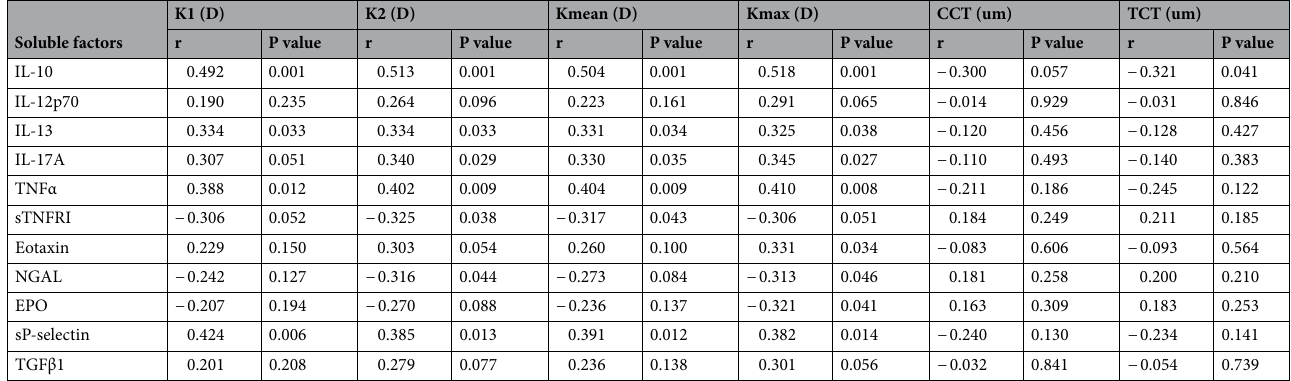
Table 3. Association of tear fluid soluble factor levels with corneal keratometry and pachymetry indices of KC patients. r = Spearman rank correlation